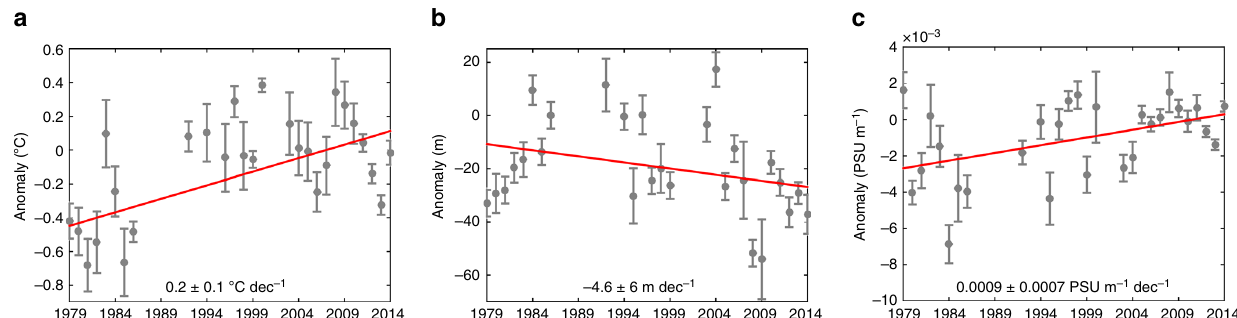
Fig. 4 1979 – 2014 observed annual time series and trends in upper ocean properties in the Ross Sea. 1979 – 2014 annual time series and trends (from in situ observations 27 ) in a 100 – 160 m mean ocean temperature, b mixed layer depth, and c salinity gradient across the top 130 m, on average over the Ross Sea areas where observed ice concentration trends are larger than 3% dec − 1 (typical interval of con fi dence for ice concentration trends). Annual means ( ± one standard error) are shown in gray . Linear trends are shown as red lines and given with their 95% con fi dence interval at the bottom of each